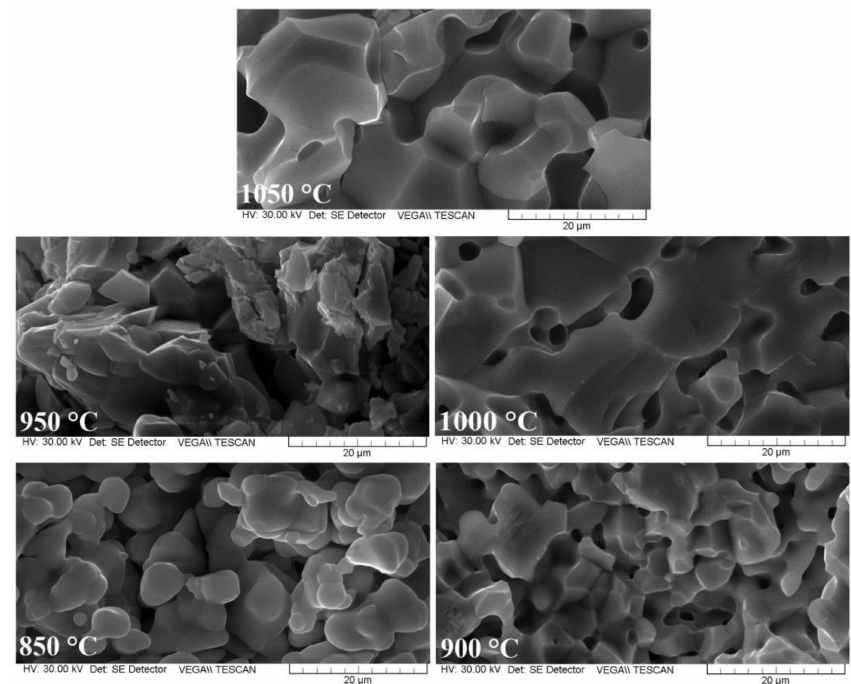
Figure 2. SEM micrographs of Mg 0.5 W 0.5 Fe 2 O 4 annealed at various